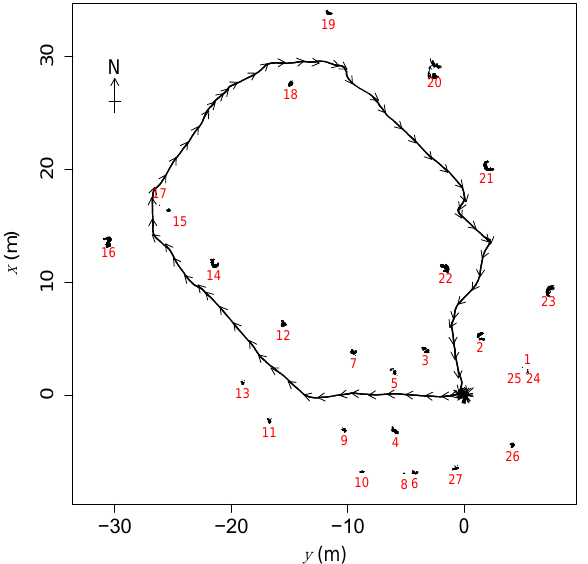
Figure 2. Map showing horizontal cross-section of plot with SLAM trajectory (curve, with arrows showing direction of UAV, starting and ending at {𝑥,𝑦} = {0,0} ) and clusters of transformed and collated LiDAR scan points (indicated by sequence numbers in red).